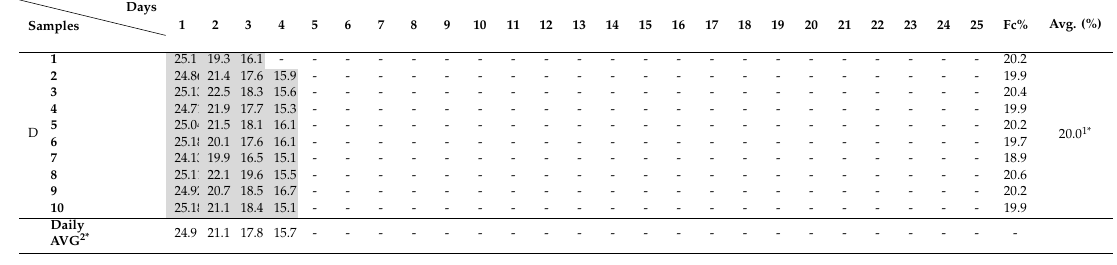
Table 14. Filler content measurement result (specimen D).